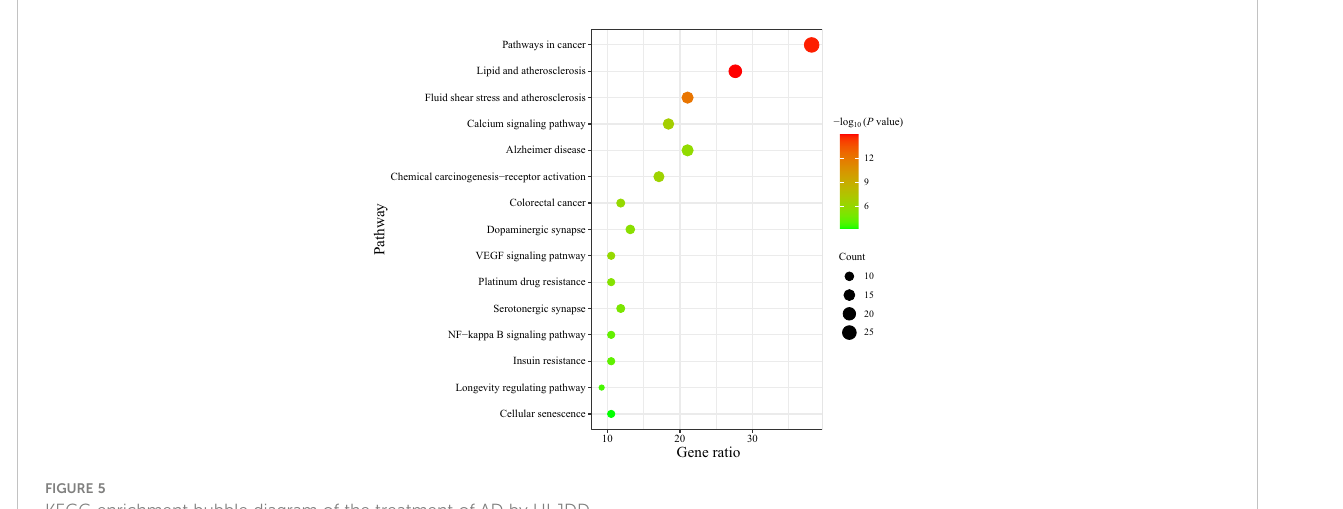
FIGURE 5 KEGG enrichment bubble diagram of the treatment of AD by HLJDD.